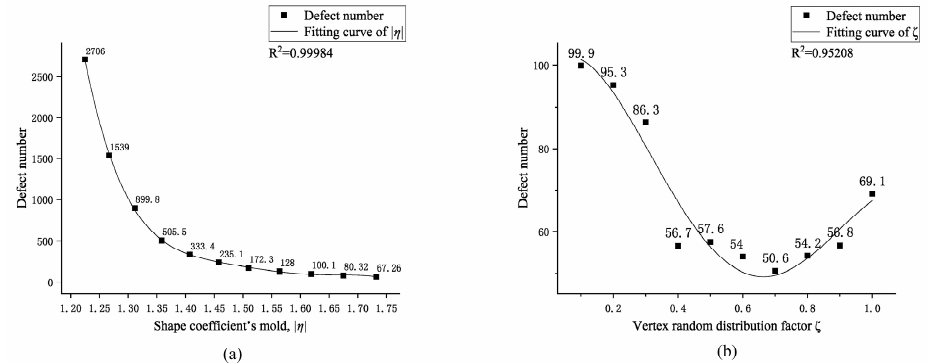
Figure 12. Non-linearly related random variables: ( a ) the mold of the shape coe ffi cient’s; ( b ) the vertex random distribution factor. Figure 11. Linearly related random variables: ( a ) number of vertices; ( b ) spherical radius.